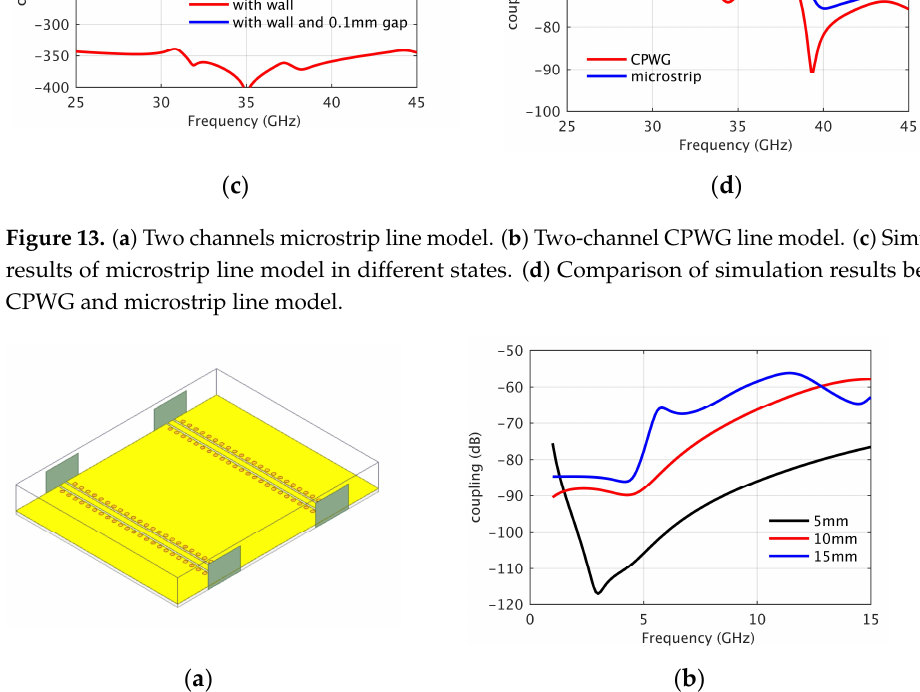
Figure 13. ( a ) Two channels microstrip line model. ( b ) Two-channel CPWG line model. ( c ) Simula- tion results of microstrip line model in different states. ( d ) Comparison of simulation results be- tween CPWG and microstrip line model.